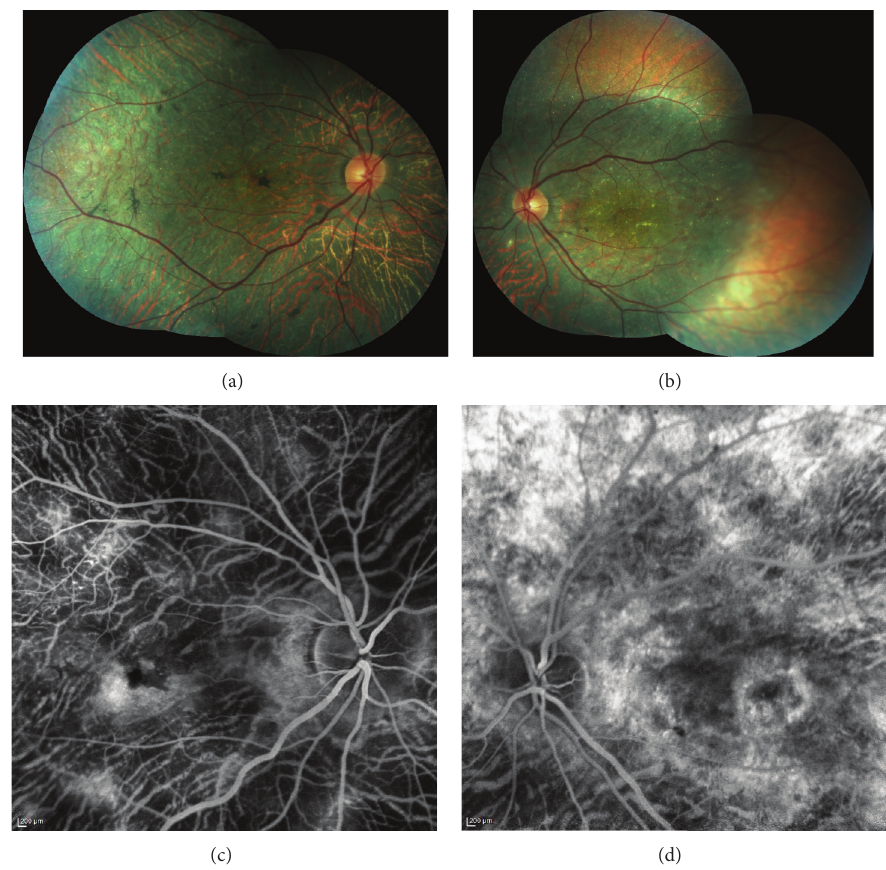
Figure 5: Color fundus pictures showing reduced numbers of intraretinal crystals and increased chorioretinal atrophy with some retinal pigment epithelial hyperplasia six years after the initial presentation. (a) Right eye and (b) left eye. Angiographic appearance of persistent cystoid macular edema. (c) Right eye and (d) left